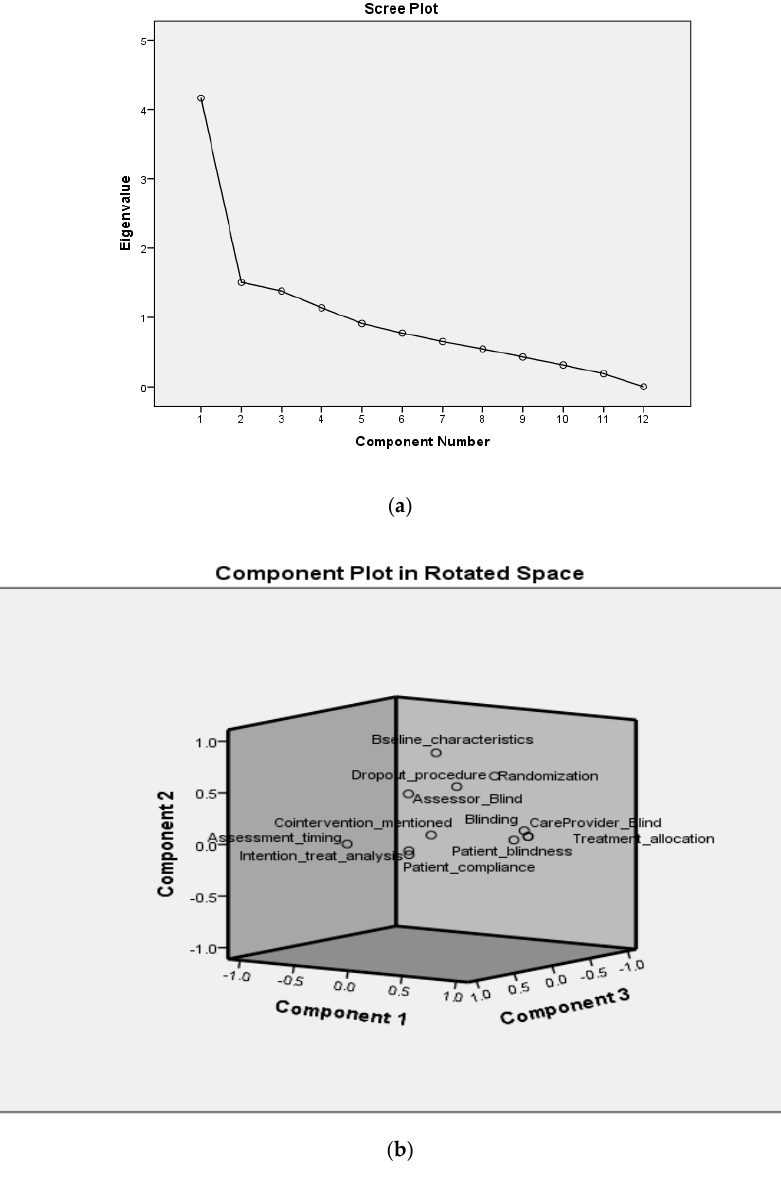
Figure 2. Scree plot ( a ) and loading ( b ) of